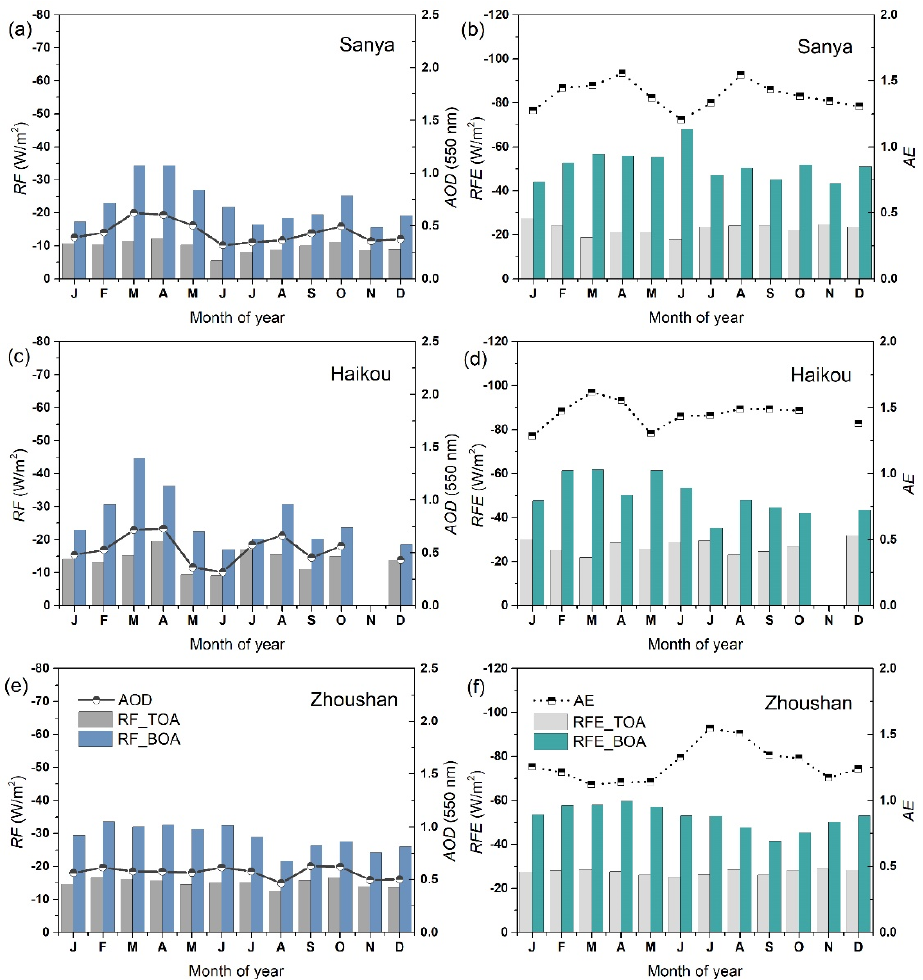
Figure 5. As Figure 2, but for the SONET coastal sites. ( a , b ) Sanya; ( c , d ) Haikou; ( e , f )